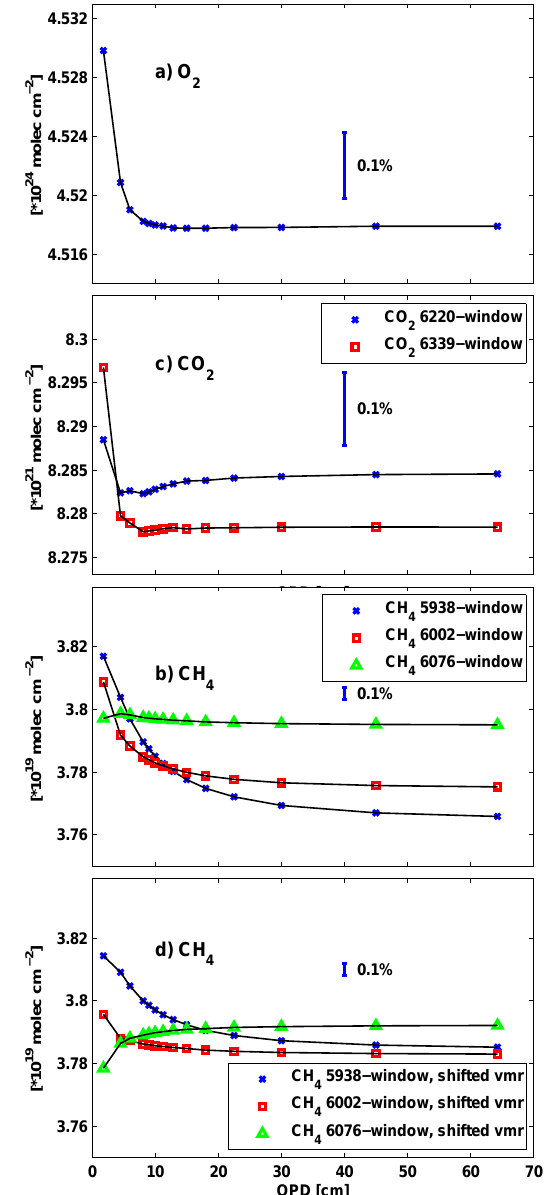
Fig. 10. Retrieved O 2 , CO 2 and CH 4 total columns from the IFS125HR, by truncating the interferograms to different optical path differences. For CO 2 and CH 4 the different retrieval windows are shown. For CH 4 the initial a-priori profile has been shifted ver- tically by − 4km. The shown bars give a percentage